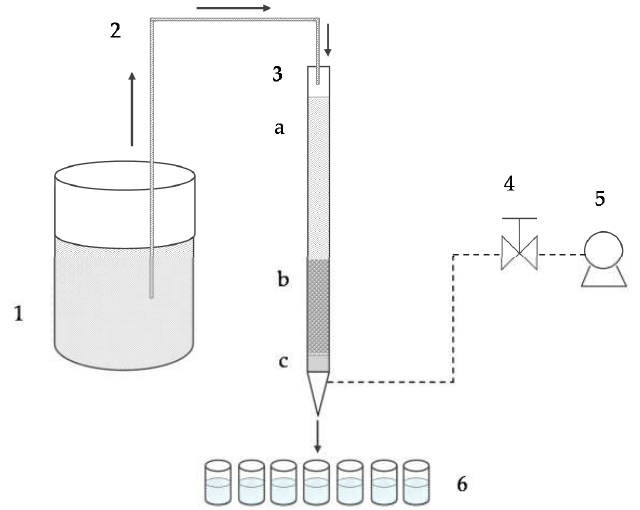
Figure 1 . A schematic representation of the laboratory column experiment: (1) binary feeding solution, (2) glass tube, (3) glass column, (a) layer of the feeding solution, (b) zeolite fixed bed of H = 8 cm, (c) glass wool for supporting the zeolite packed bed, (4) flow rate setting, (5) vacuum pump, and (6) effluent samples.